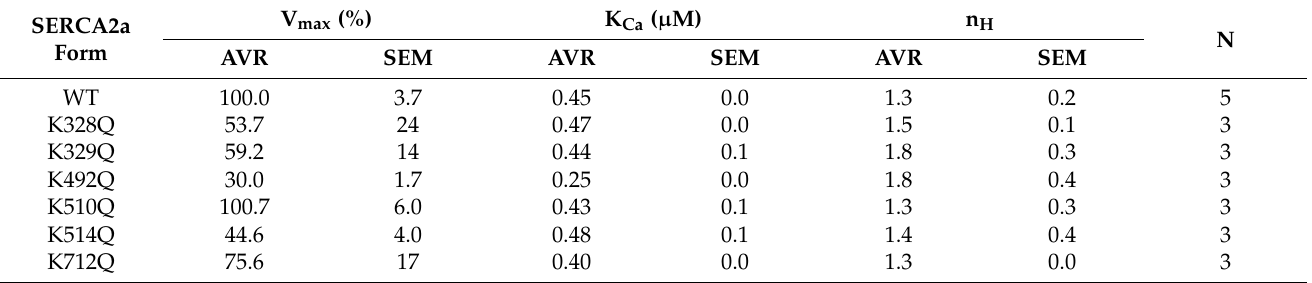
Table 2. Kinetic parameters for wild-type and acetylation mimicking mutants of SERCA2a.